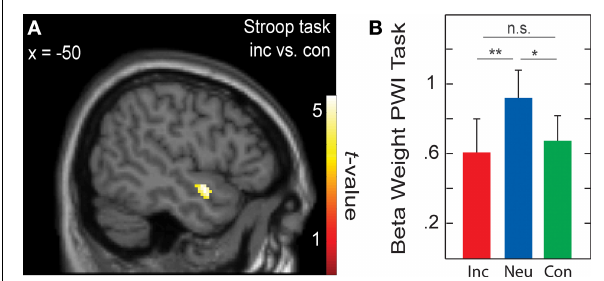
FIGURE 3 | (A) Active voxels for incongruent versus congruent in the Stroop task (BA 38; peak MNI: − 50, 0, − 12; and − 46, − 10, − 12). (B) Averaged beta weights of active voxels in (A) in the picture-word interference (PWI) task as a function stimulus type. Inc, incongruent; Neu, neutral; Con, congruent; n.s., non-significant. Error bars represent the standard error of the mean. ∗ p -values ≤ 0.05, ∗∗ p -values ≤